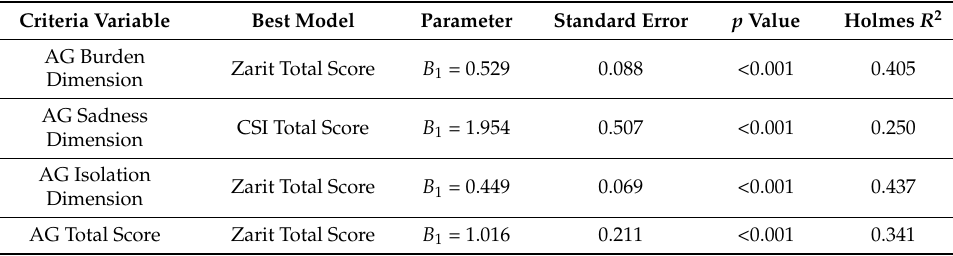
Table 5. Parameter estimation of the stepwise linear regression to predict Anticipatory